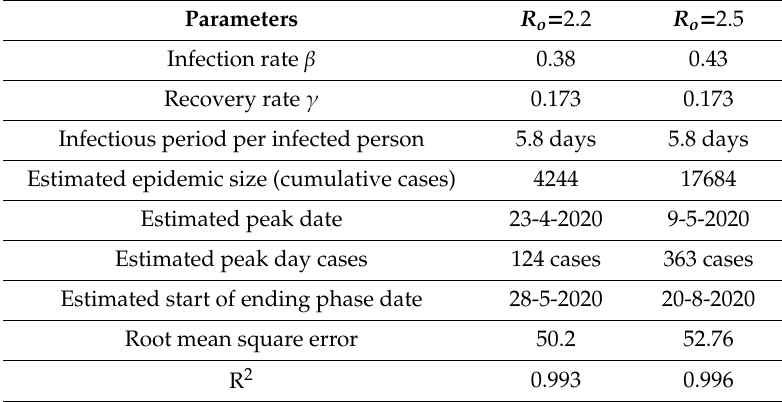
Table 5. Susceptible–infected–recovered (SIR) simulation results with R o = 2.2 and R o =